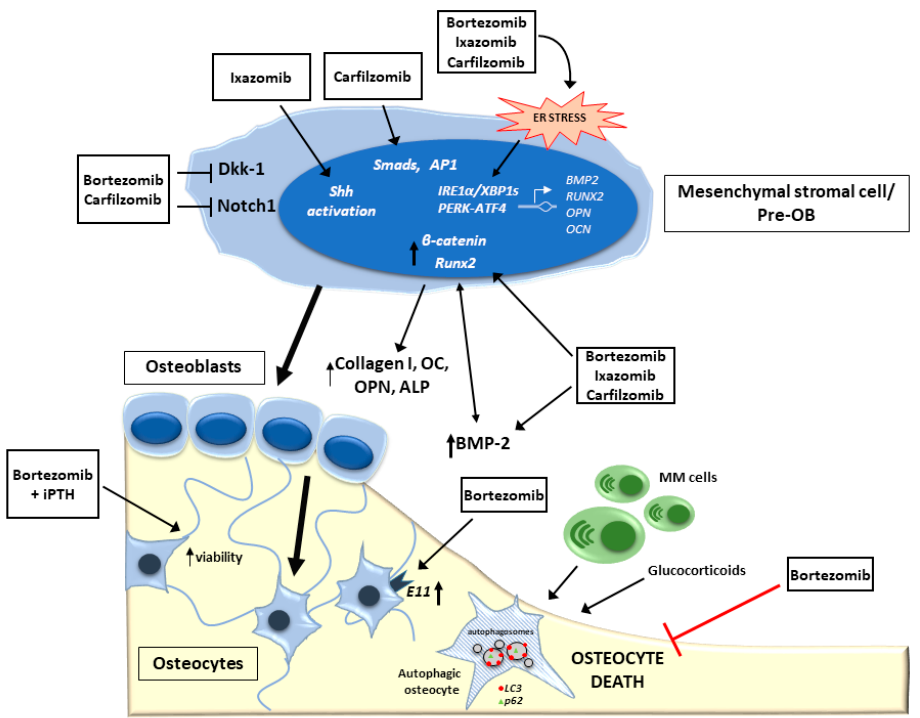
Figure 2. Biological consequences of proteasome inhibition in MM bone microenvironment. PIs increase the activity of Runx2 in pre-OBs with a consequent increased expression of collagen I, OC, OPN, and ALP through a Wnt-independent stabilization of β -catenin. Bortezomib also increases BMP-2 expression in osteoblastic cells that, in turn, increase the levels of the transcription factor Runx2, enhancing bone formation. The treatment with carfilzomib enhances the activity of Smads and AP1 transcription factors, promoting early OB progenitors’ commitment. The bone anabolic effect of PI treatment, in particular bortezomib and carfilzomib, has been correlated with Notch1 and Dkk-1 inhibition with subsequent enhancement of OB formation. Bortezomib and ixazomib promote the ER stress, mainly through the activation of IRE1 α /XBP1s and PERK-ATF4 signaling pathways leading to increased expression of OB markers. The anabolic effect of ixazomib is also associated with the activation of SHH pathway by inducing the nuclear translocation of Gli1 in MSCs and OB differentiation. MM cells and high doses of glucocorticoids induce autophagic death in osteocytes by modulating the levels of two autophagic markers LC3 and p62. Bortezomib blunts osteocyte death by reducing LC3 and increasing p62 protein levels. Bortezomib also potentiates the effect of intermittent PTH on osteocyte viability. Additionally, bortezomib stabilize the transmembrane glycoprotein E11, leading to increased osteoblast–osteocyte